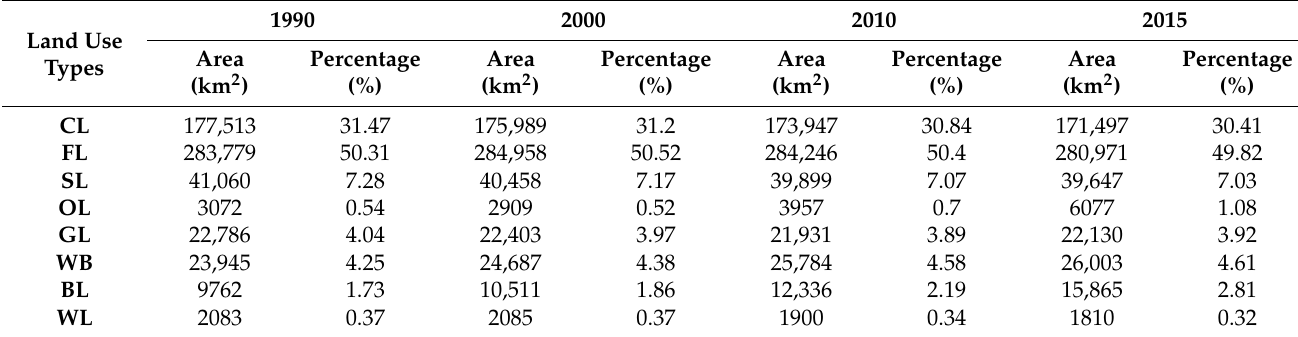
Table A2. Changes in area of land use types in the MRYRR region from 1990 to 2015.